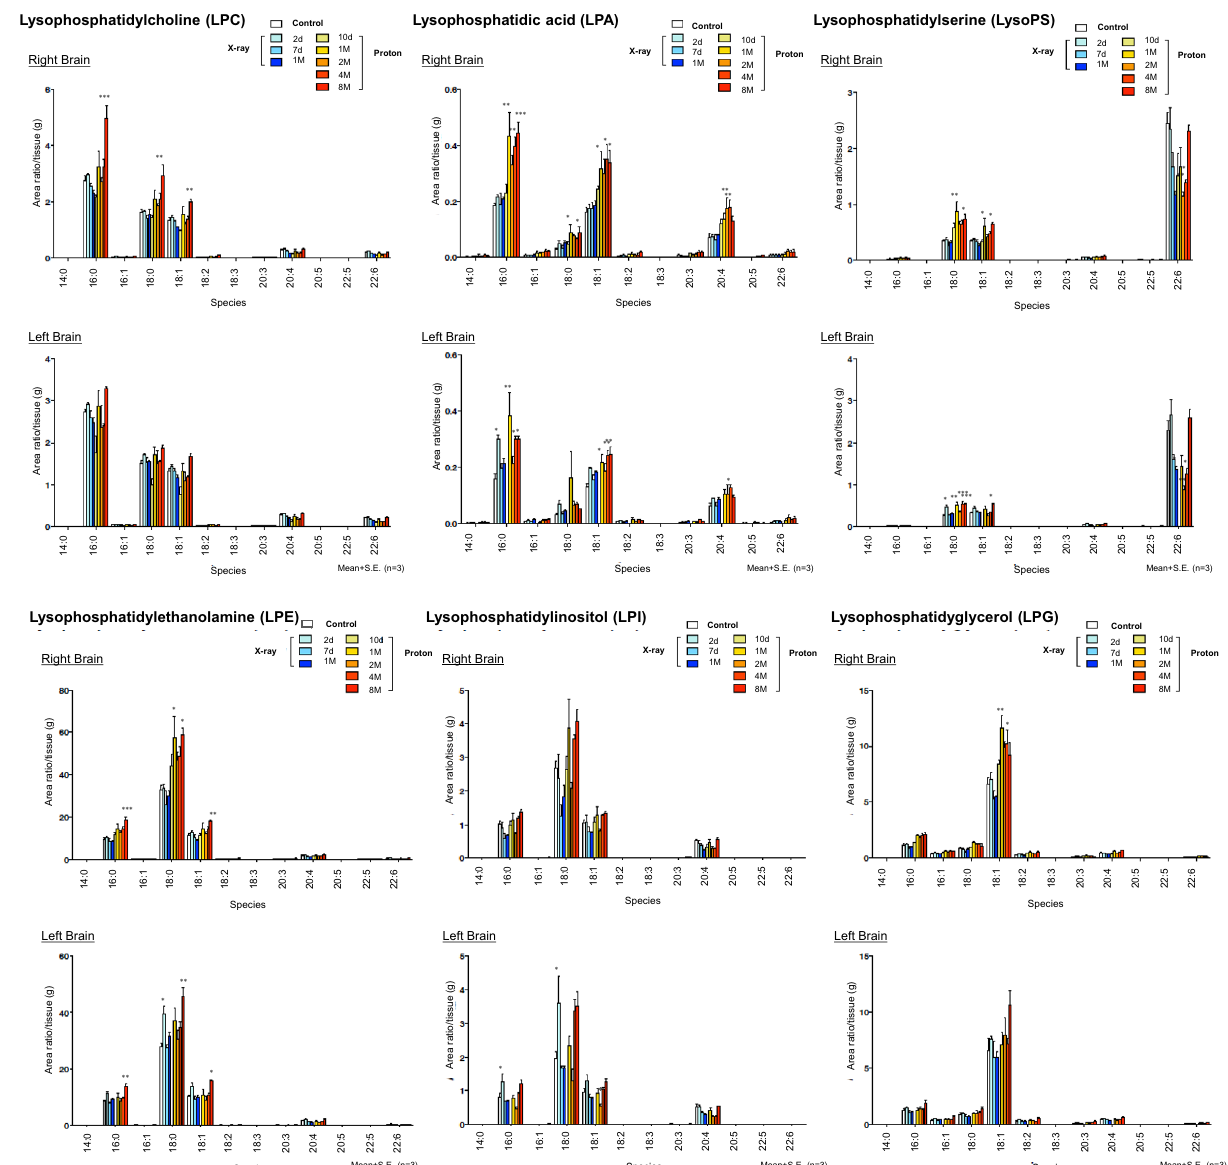
Figure 2. Lysophospholipid changes after irradiation in the brain RN model as detected by LC–MS/MS. Quantitative changes of lysophosphatidylcholine (LPC), lysophosphatidyl acid (LPA), lysophosphatidylserine (LPS), lysophosphatidylethanolamine (LPE), lysophosphatidylinositol (LPI), and lysophosphatidylglycerol (LPG) of the right or left hemisphere of control or irradiated mice at 10 days, 1 month, 2 months, 4 months, or 8 months after proton beam irradiation, or at 2 days, 7 days, and 1 month after X-ray irradiation ( n = 3 per group). Upper graphs indicate the right hemisphere and lower graphs indicate the left hemisphere. S. E. standard error. * P < 0.05, ** P < 0.01, *** P < 0.001 versus non-irradiated control mice; one-way analysis of